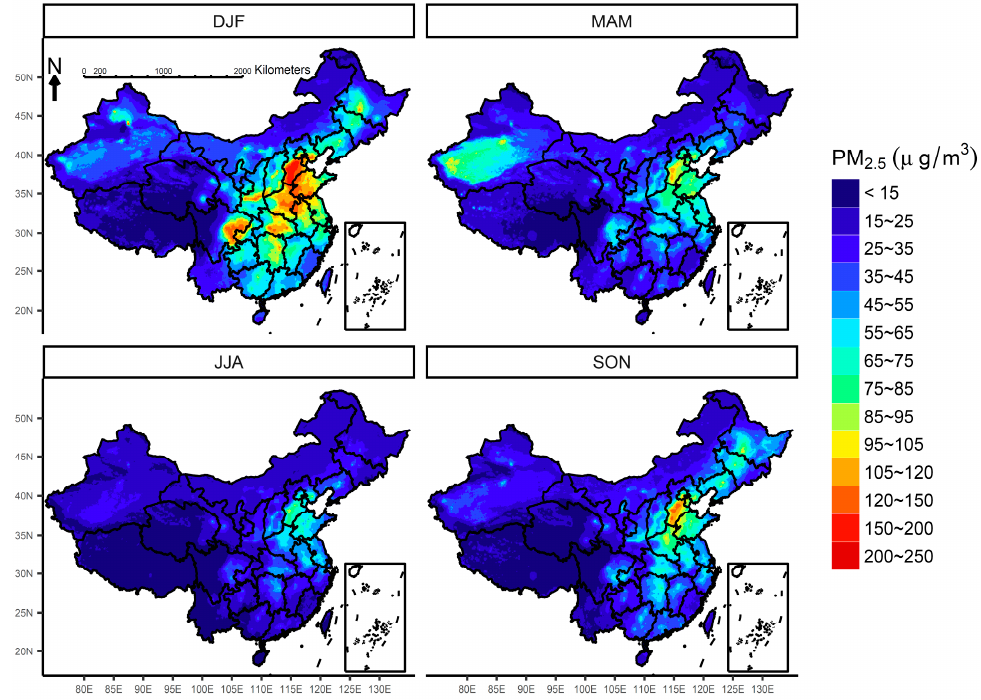
Figure 7. Seasonal maps (0.1° × 0.1°) of PM 2.5 during 2014 over China produced by the three-stage model (PM 2.5Optimal ).